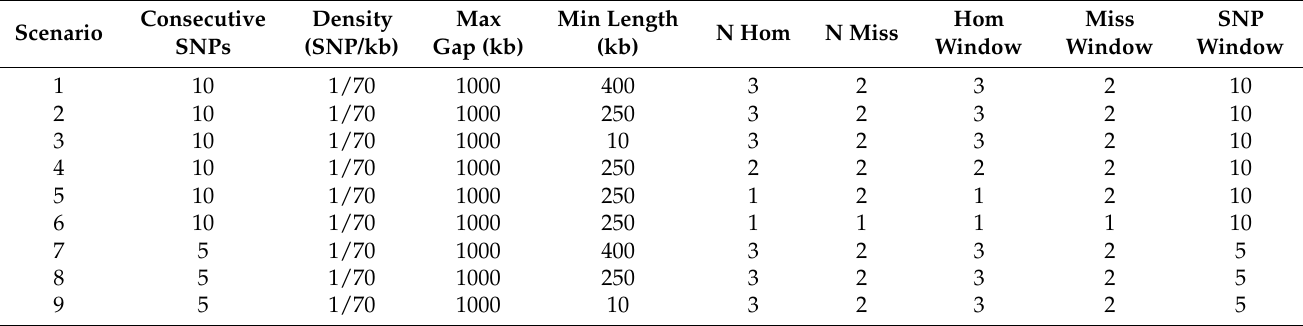
N hom = maximum number of homozygous SNPs allowed in an HRR, N miss = maximum number of missing SNPs allowed in an HRR, Hom window = maximum number of homozygous SNPs allowed in a window, Miss window = maximum number of missing SNPs allowed in a window, SNP window = number of SNPs in a